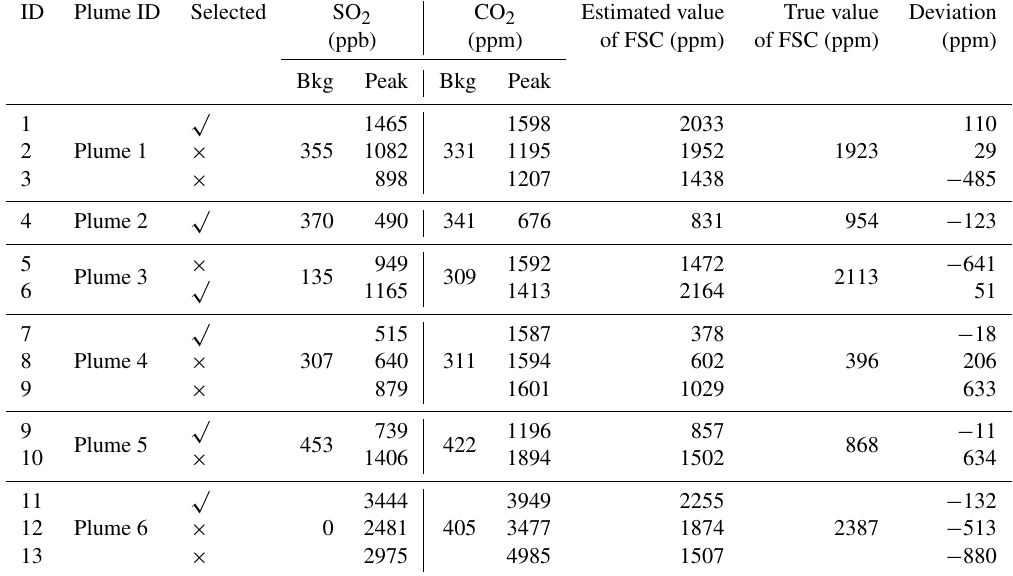
Table 2. Comparison and verification of the estimated and true values of FSC. We present the selected background (Bkg) and peak values of SO 2 and CO 2 and alternative peak values (mentioned in Fig. 5). The FSC results and deviations of these different values are also listed for comparison purposes. They are distinguished as follows in the column titled “Selected”: the selected peak values are marked as “ indicate the selected peak values, and “ × ” indicates alternative peak values (which are not selected as the calculated values in the final result of